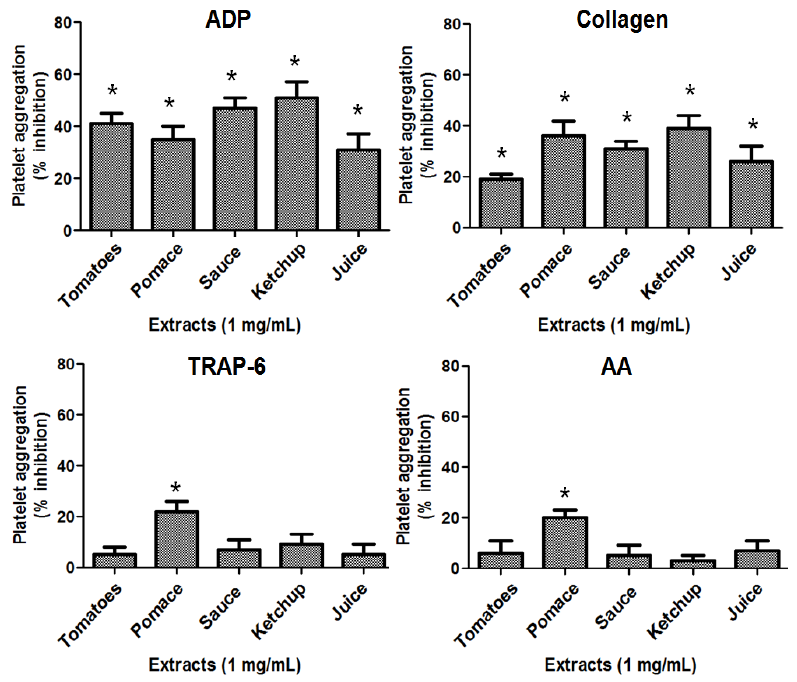
Figure 1. Quantitation of the inhibitory effect of tomato and its products on platelet aggregation induced by ADP (8 µmol/L), collagen (1.5 μ g/mL), TRAP-6 (30 µmol/L) or AA (1 mmol/L). Results were expressed as % inhibition (mean ± SEM, n = 3). * p < 0.05 vs . negative control (saline